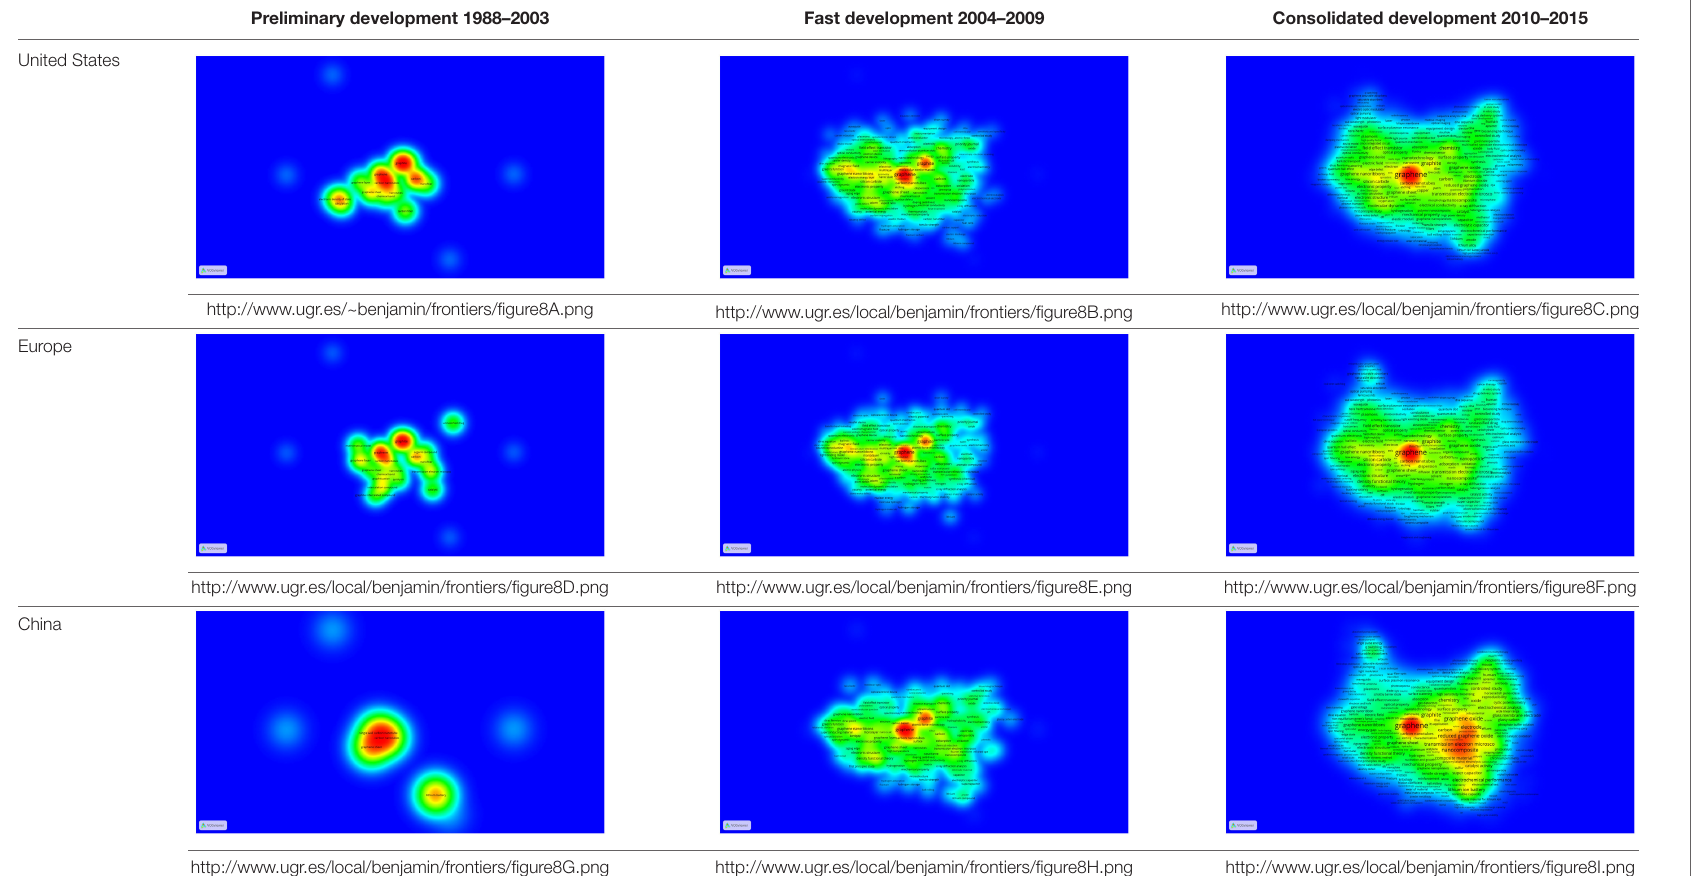
TaBle 8 | Density